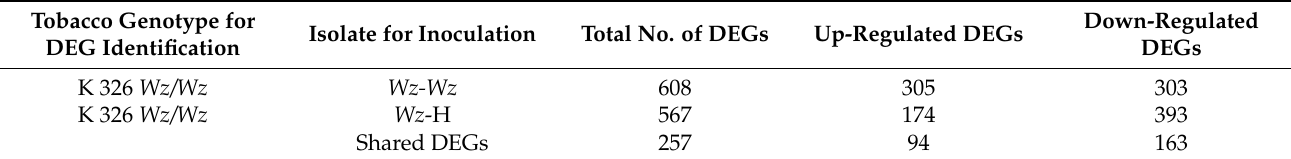
Table 7. Number of DEGs identified in K 326 Wz/Wz inoculated with either the Wz-Wz or the Wz -H isolate of P. nicotianae compared to Hicks inoculated with the same